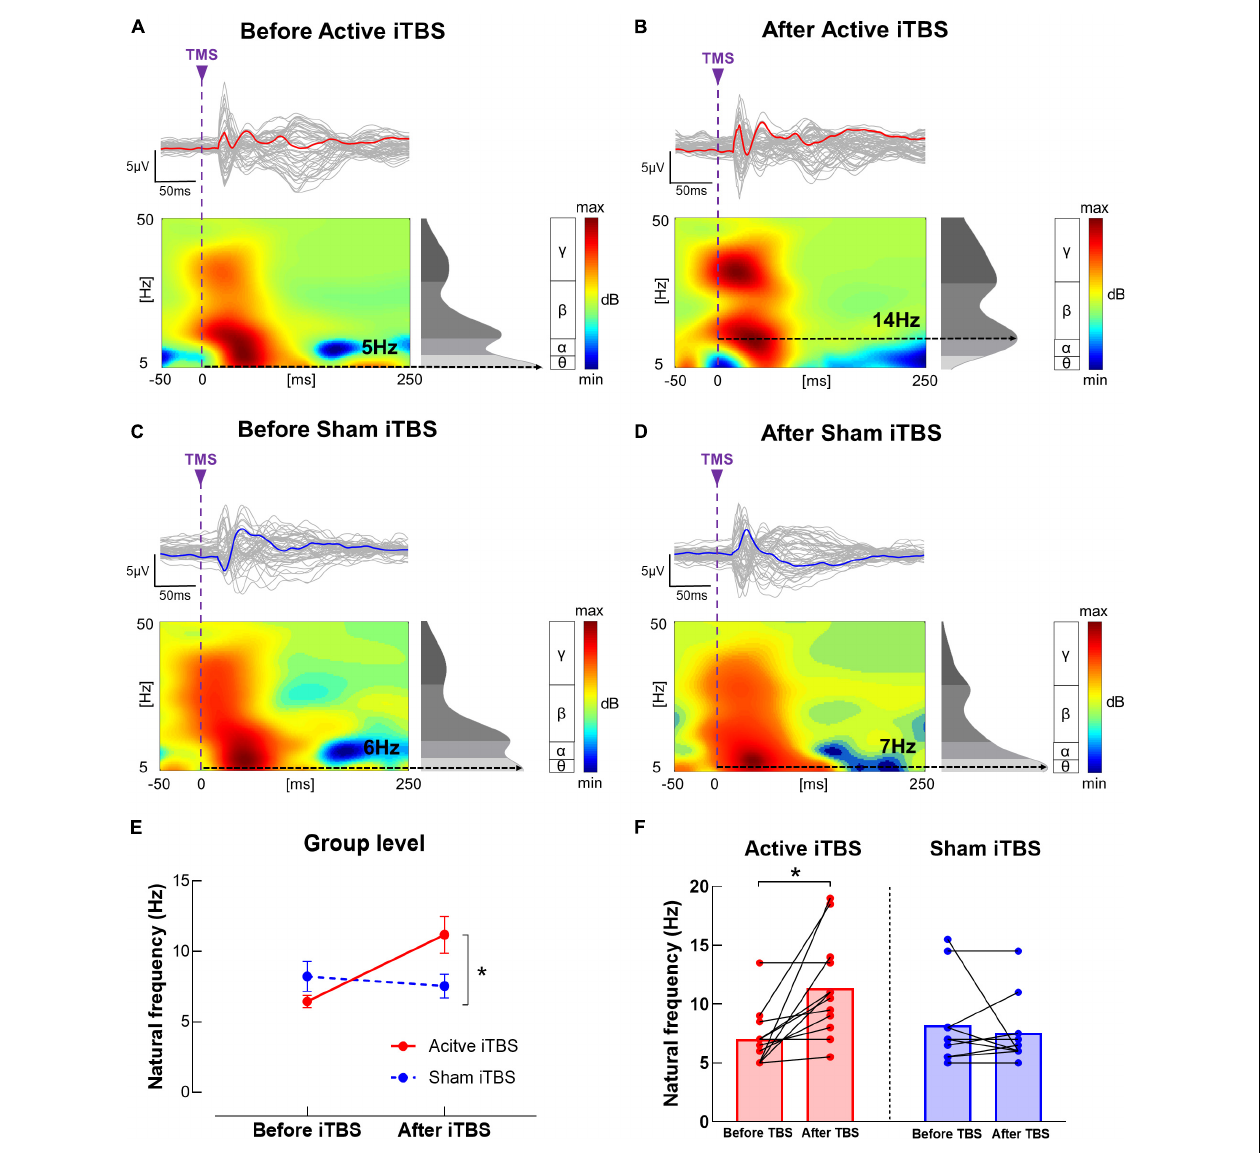
FIGURE 5 | Natural frequency changes after iTBS. (A–D) Illustration of TEP, ERSP and natural frequency in the IH before and after iTBS in representative subjects in the Active (A,B) and Sham (C,D) iTBS groups. The gray curves represent TEP in each channel, and the bold curves represent the averaged TEP in the channels surrounding the stimulated motor cortex. The ERSP plots show the TMS-evoked oscillatory responses in amplitude and duration, with black dotted lines highlighting the frequency with the highest power (i.e., natural frequency). (E) Data presented are group mean ± standard error. In the Active iTBS group, IH natural frequency was significantly increased after iTBS; while in the Sham iTBS group, there was no significant change in natural frequency after iTBS. (F) Illustration of individual changes in IH natural frequency after iTBS in both groups. The red circles represent the Active iTBS group, and the blue circles represent the Sham iTBS group.